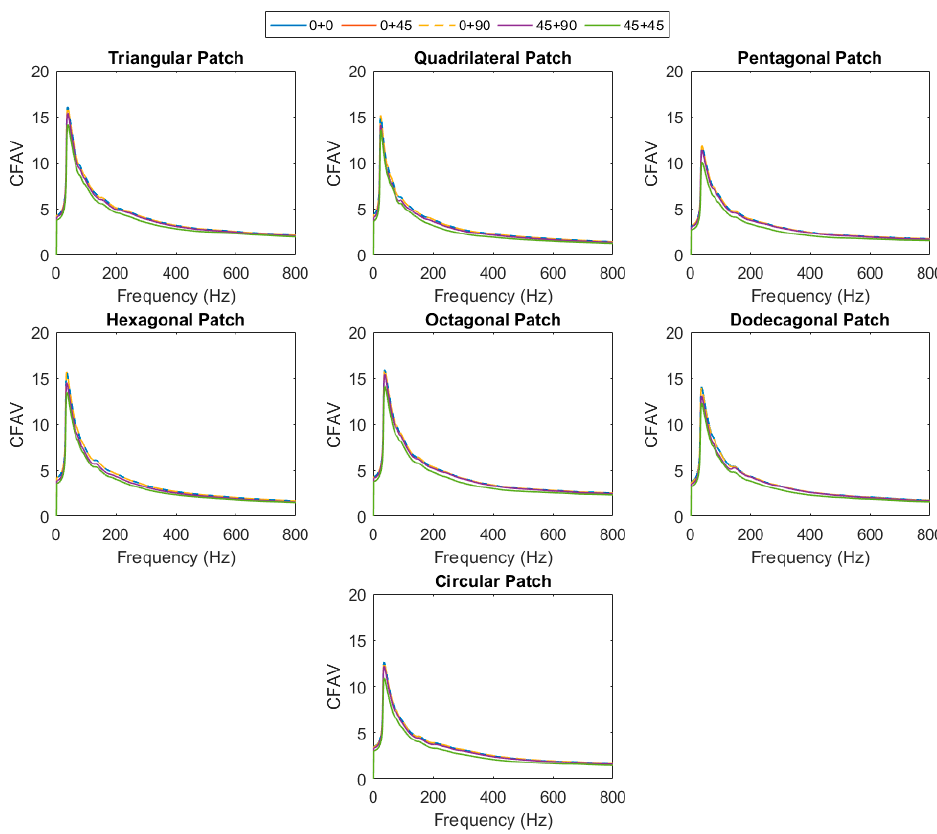
Figure 12. CFAV of the piezoelectric patches for optimal fiber orientation for double-lamina.